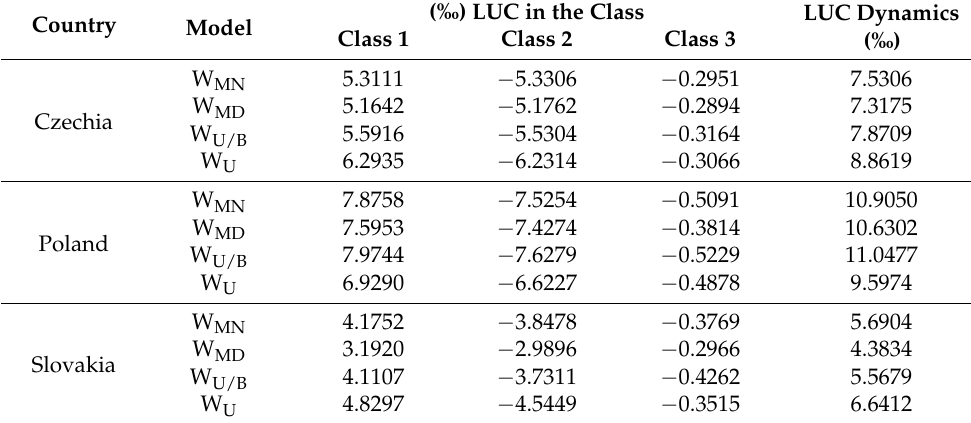
Table 3. Values of models and LUC dynamics at the national level in per mille for each country. (‰) LUC in the Class LUC Dynamics Country Model (‰)Class 1 Class